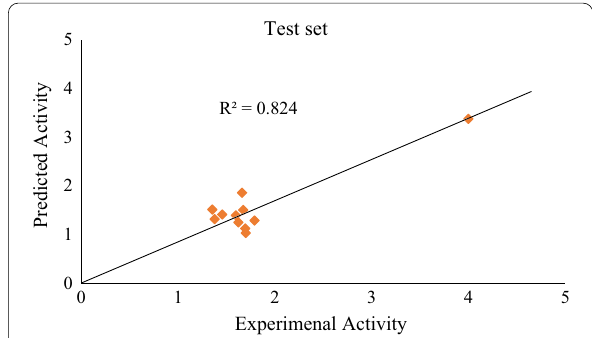
Fig. 2 Plot of experimental activity against predicted activity of the test set